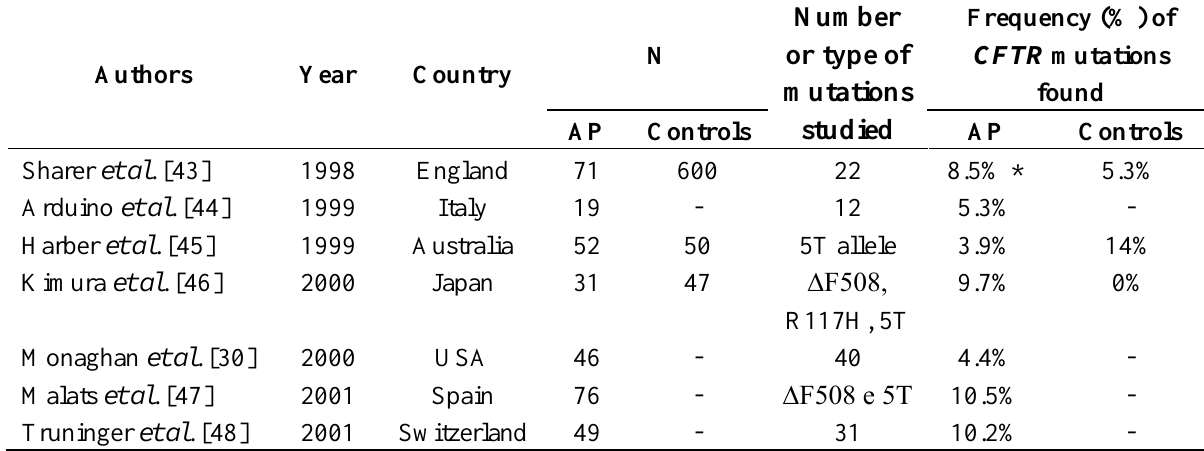
Table 1. Comparison of studies investigating mutations in the CFTR gene in patients with alcoholic pancreatitis